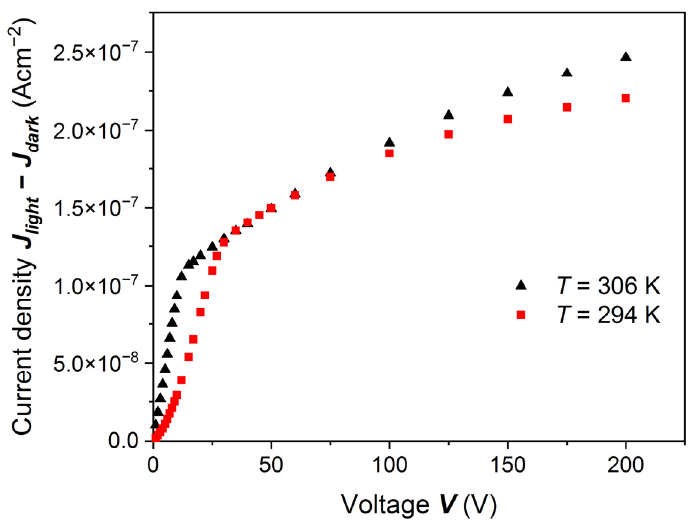
Figure 11. PC-V characteristics measured at two slightly different temperatures. The results were obtained on a (Cd,Mn)Te:In sample etched with 20% HCl but different from the one whose results were presented in Figures 6 and 8–10. The excitation energy was equal to ħω = 1.608 eV = E g + 33 meV. Below 30 V at 294 K, the dependence is power like. It changes shape after raising temperature up to 306 K (by about 4%) and resembles the Hecht–Many function. The conducting electrons may appear due to thermal ionization of surface trapping. In this sample deep traps must also exist, e.g., tellurium antisites Te Cd2+ . Deep traps can be emptied by the application of higher voltages. Thus, in a voltage range higher than 50 V the increase of the PC-V signal is noticed.